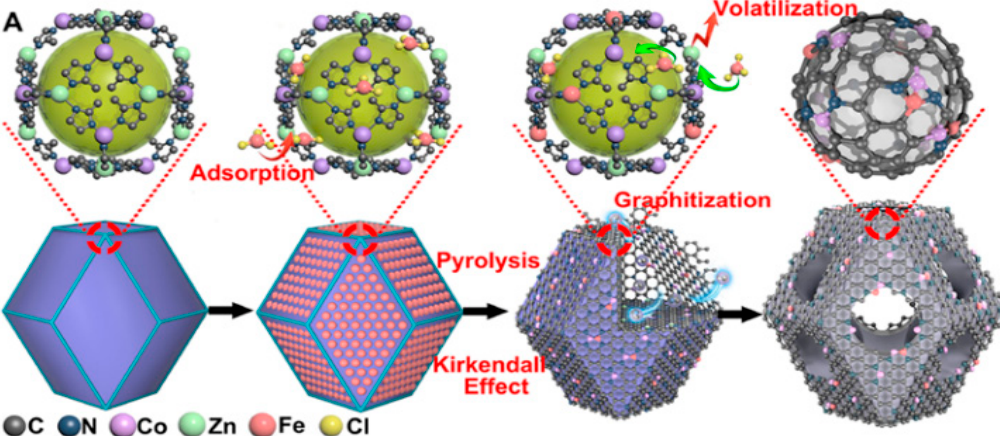
Figure 8. Preparation route of (Fe,Co)/N–C, reproduced with permission from [52]. Copyright American Chemical Society, 2017.